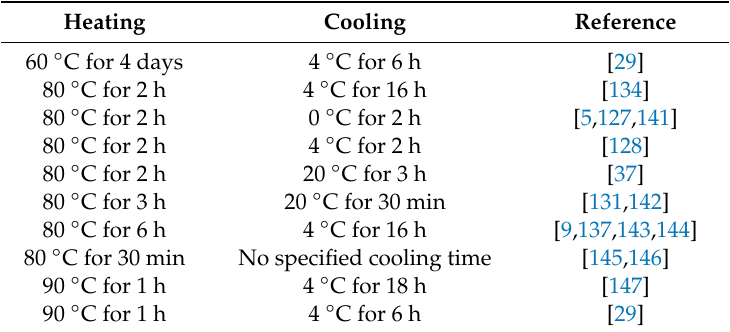
Table 2. Heat test conditions recommended for heating and